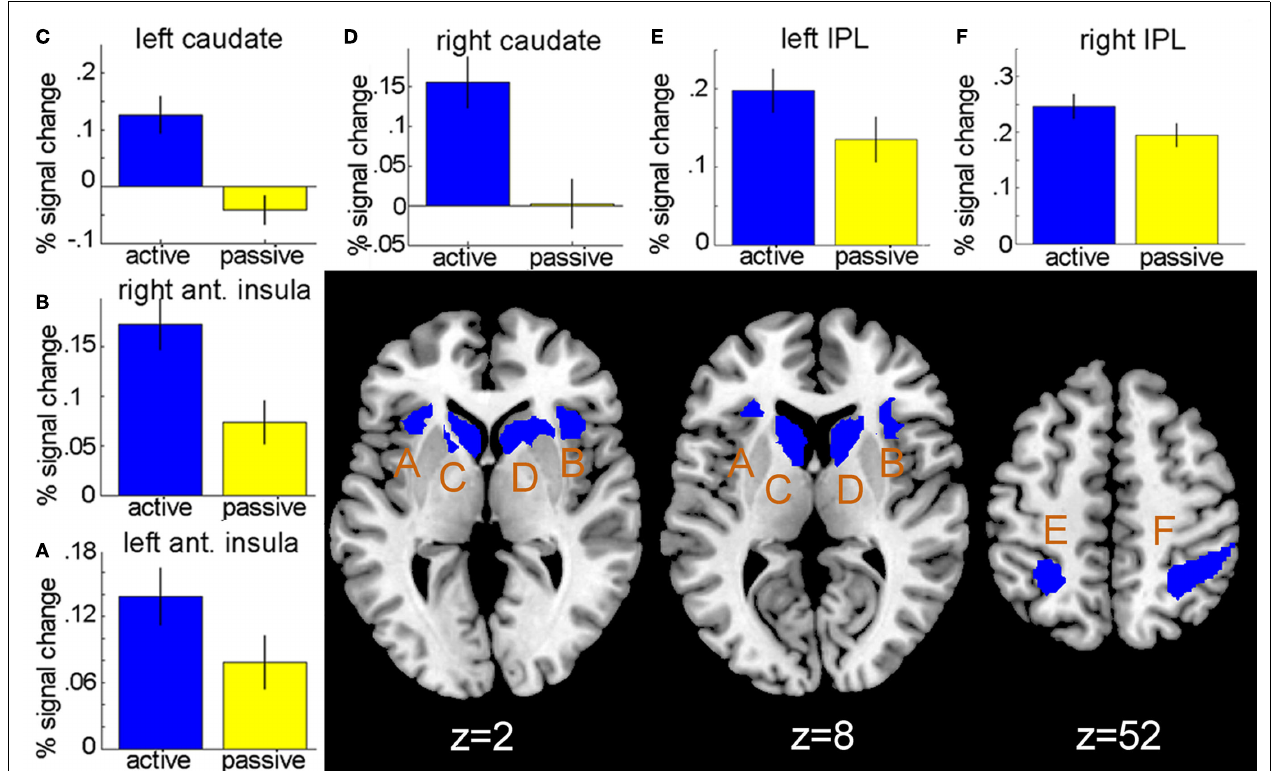
inferior parietal lobe (IPL) bilaterally (peaks at − 24, − 54, 52; 34, − 48, 40). Results are displayed at P < 0.05, FDR-corrected. Bar graphs show percent signal change at peak voxels [ (A,B) : anterior insula, (C,D) : caudate, (E,F) : IPL] during bet selection for the two choice conditions. Error bars represent SEM.